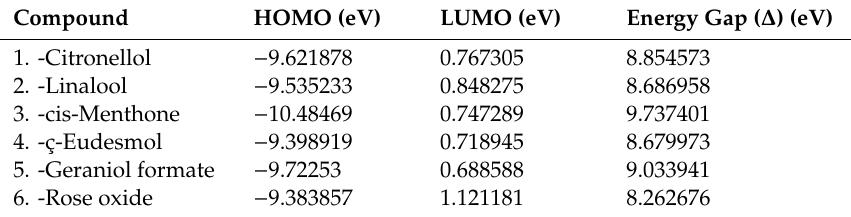
Table 2. HOMO and LUMO values of the studied compounds using MNDO